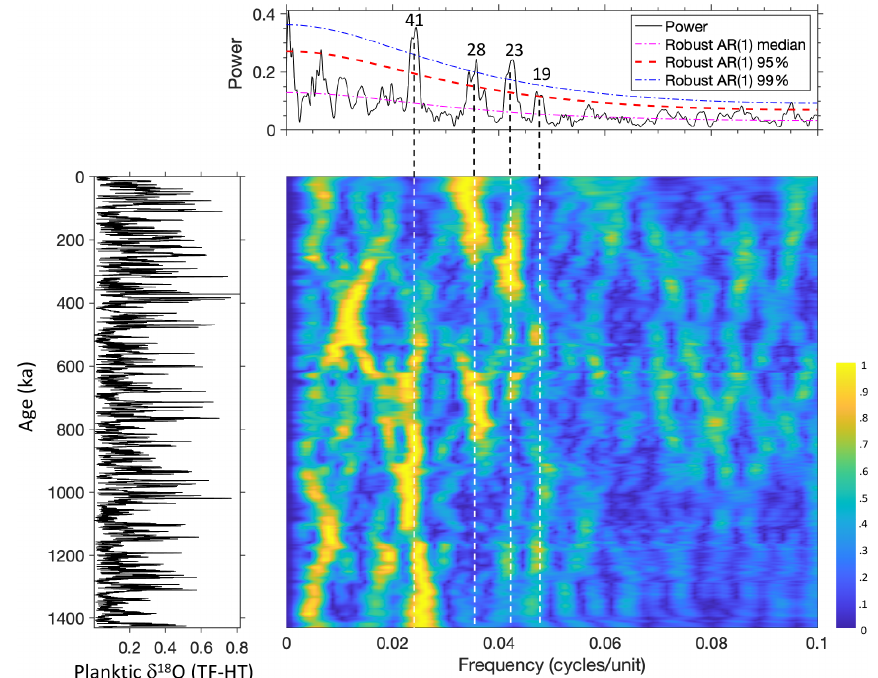
Figure 15. Evolutive power spectrum of the amplitude modulation of planktic δ 18 O as estimated from a Taner filter (TF) centred at 0 . 55 ± 0 . 45 and Hilbert transformation (HT) of the time series. Sliding window of ∼ 300kyr with time domain zero padding and a step equal to the